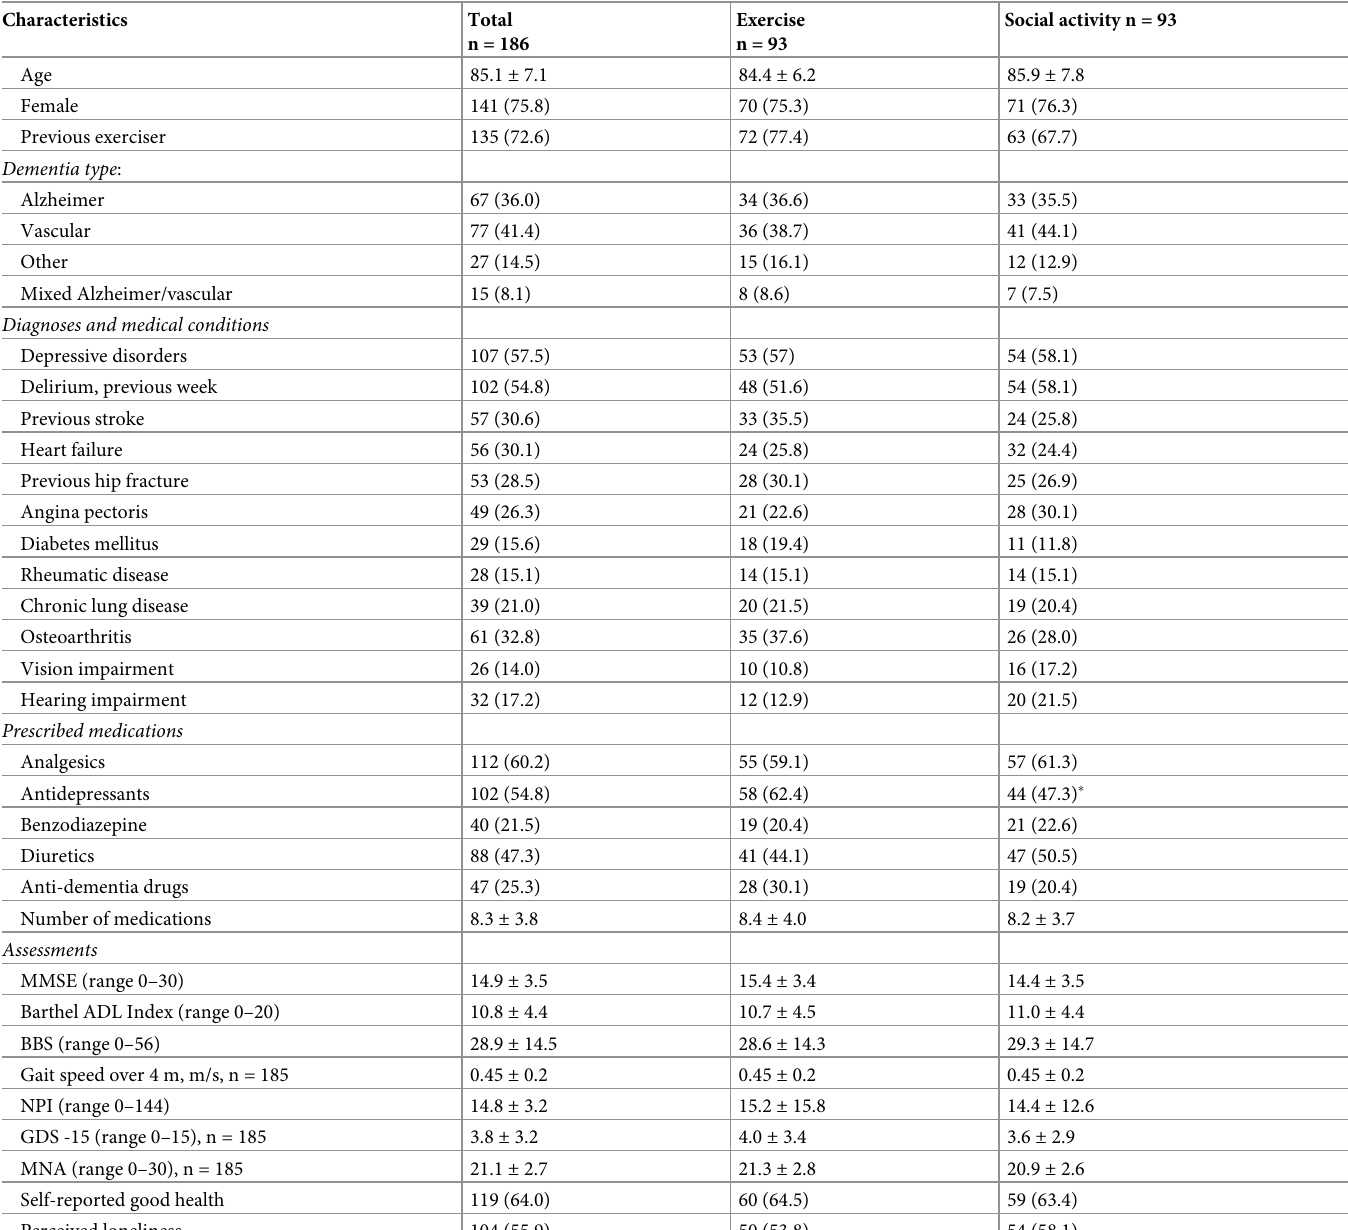
Table 1. Baseline characteristics of